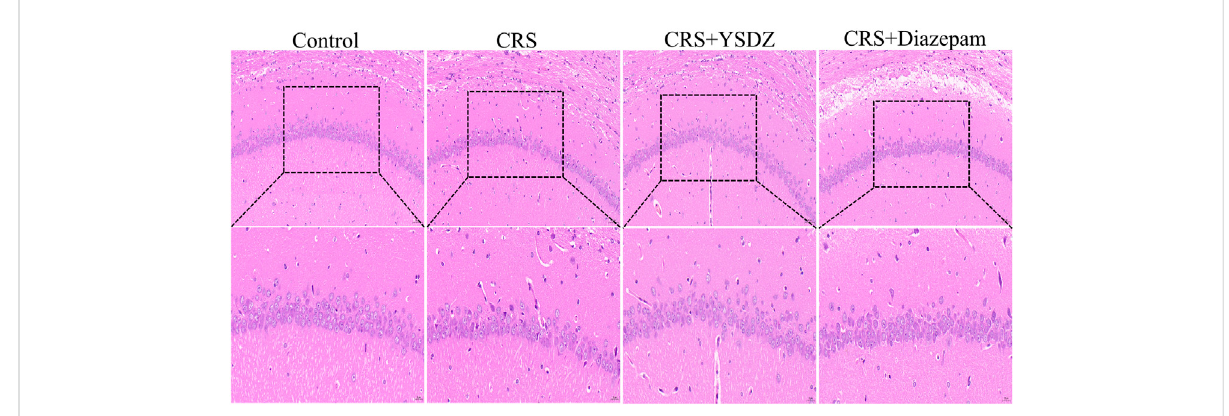
FIGURE 5 Histological changes in hippocampus.